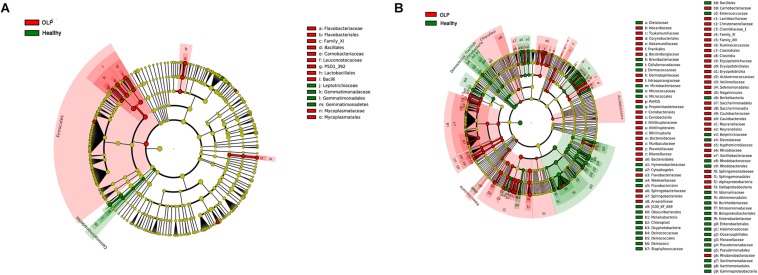
LEfSe analysis cladogram of saliva and tissue samples between the healthy controls and the OLP. (A) Saliva samples’ LEfSe analysis cladogram. (B) Tissue samples’ LEfSe analysis cladogram. Colored nodes from the inner to the outer rings, respectively, represent the level of phylum (p), class (c), order (o), family (f), and genus (g); only the level of class to family was labeled and annotated on the right side of the cladogram. Differences were indicated by different colors: green for healthy controls, red for OLP, and yellow for non-significant. The diameter of each circle was proportional to the abundance of the taxa.